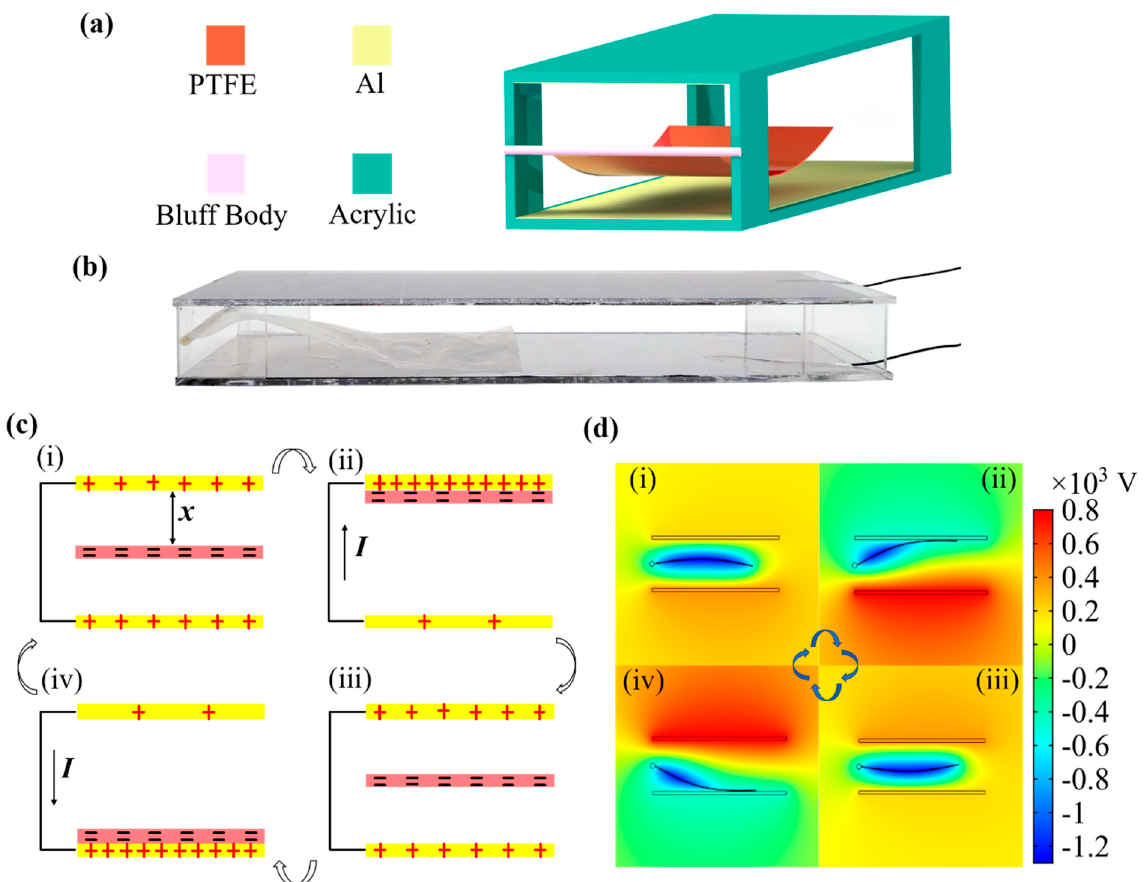
Figure 1. ( a ) Schematic of the flutter-driven triboelectric nanogenerator (FTENG), ( b ) Photograph of the FTENG, ( c ) Schematic of the working mechanism of FTENG, and ( d ) Finite-element simulation of the electrostatic potential distribution of the FTENG.